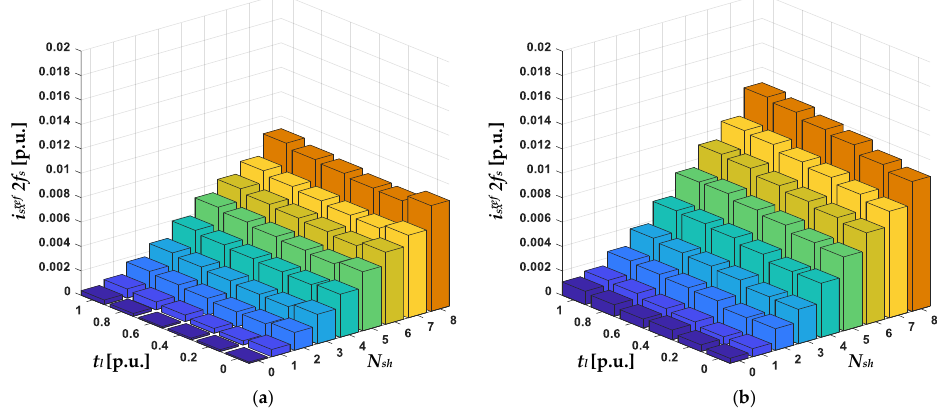
Figure 11. Amplitudes of the f sh harmonic of the i sx reference current component for different numbers of short-circuit turns and different load torques with ω m = 0.6 ω mN in the case of ( a ) speed measurement and ( b ) sensorless operation.